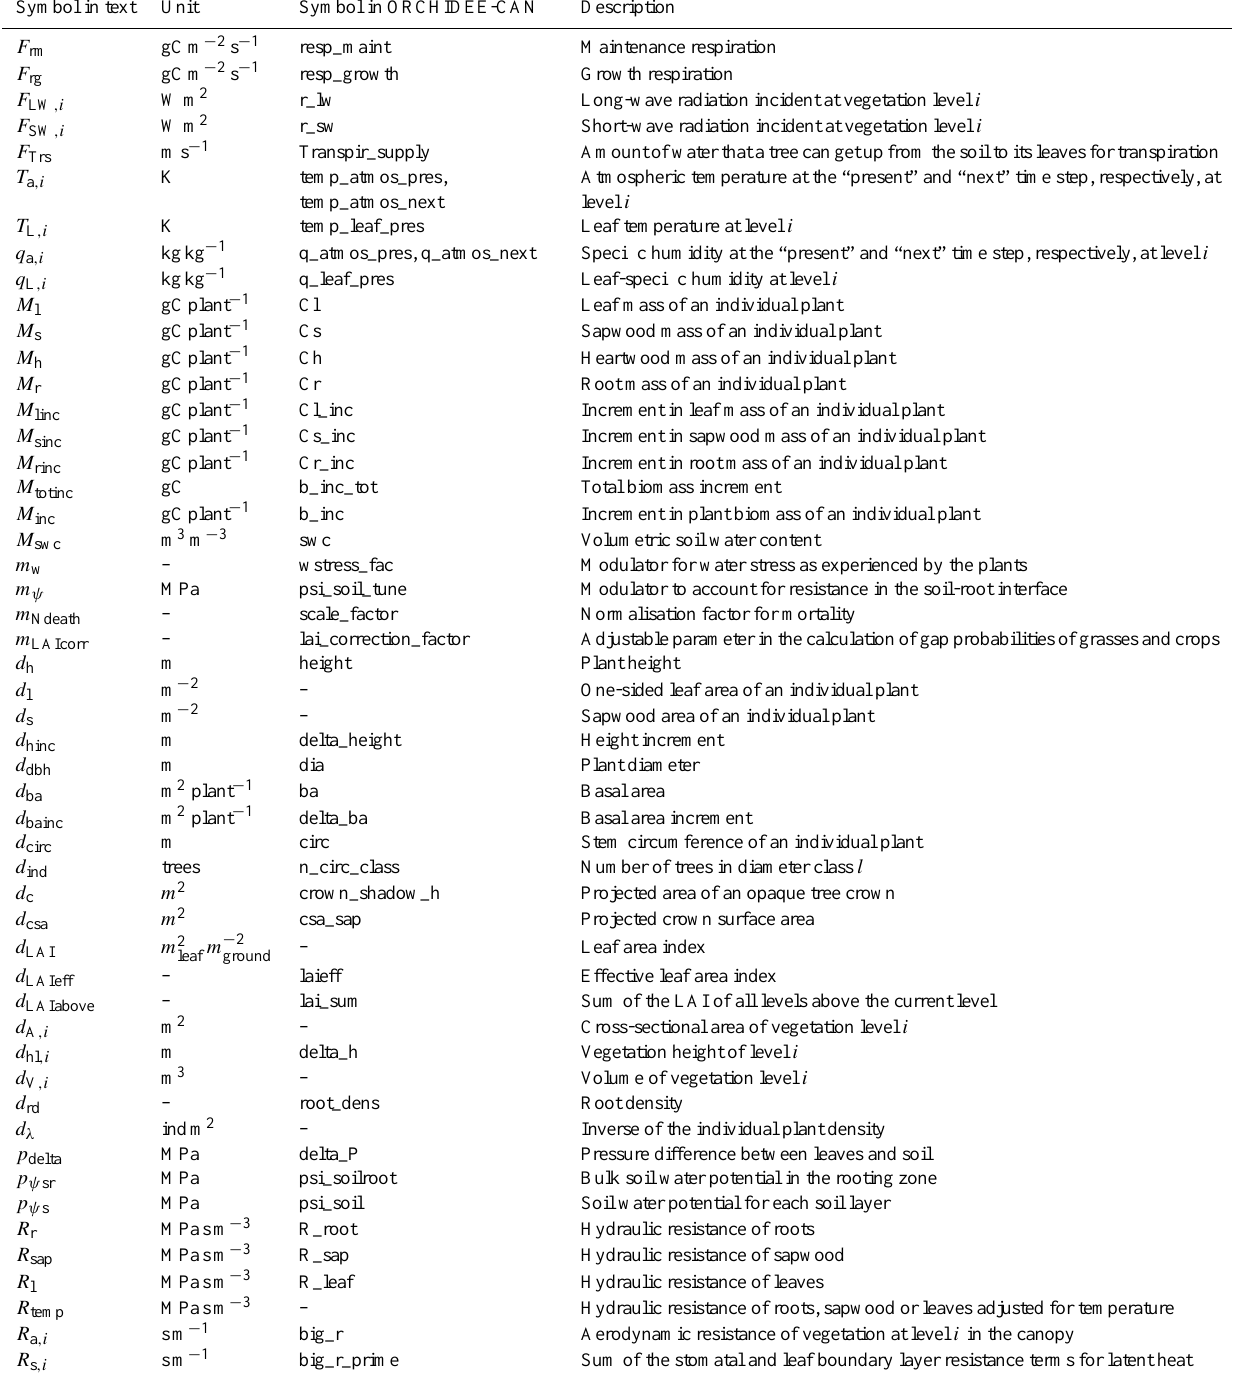
Table 2. Variable description. Variables were grouped as follows: F = flux, f = fraction, M = pool, m = modulator, d = stand dimension, T = temperature, p = pressure, R = resistance, q = humidity, g =